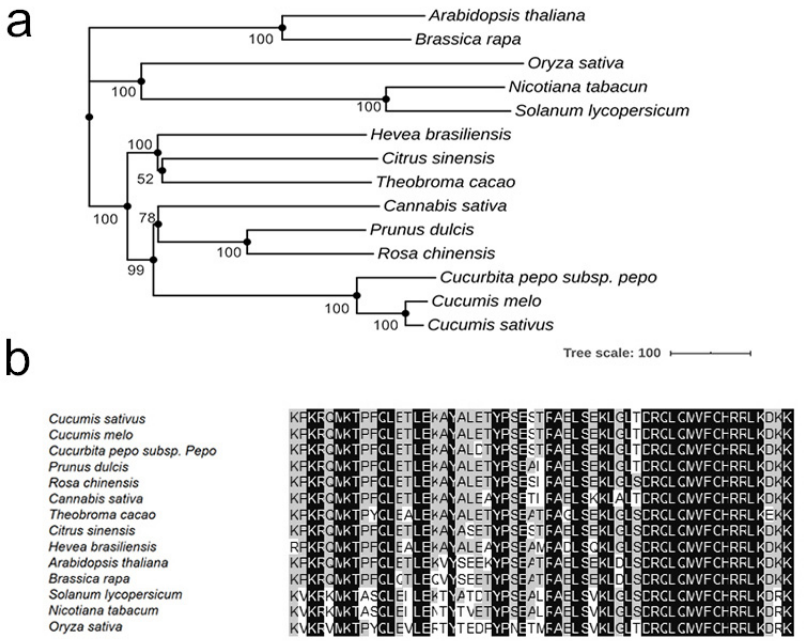
Figure 4. Phylogenetic relationships of cucumber CsHD1 and CsHD1 homologs with other selected plant species. ( a ) A neighbor-joining tree for HD-DDT transcription factor sequences with MEGA 7.0. The numbers at the branch points represent bootstrap values (%) of 1000 replications. ( b ) The conserved homeobox domain of DHD homologs.